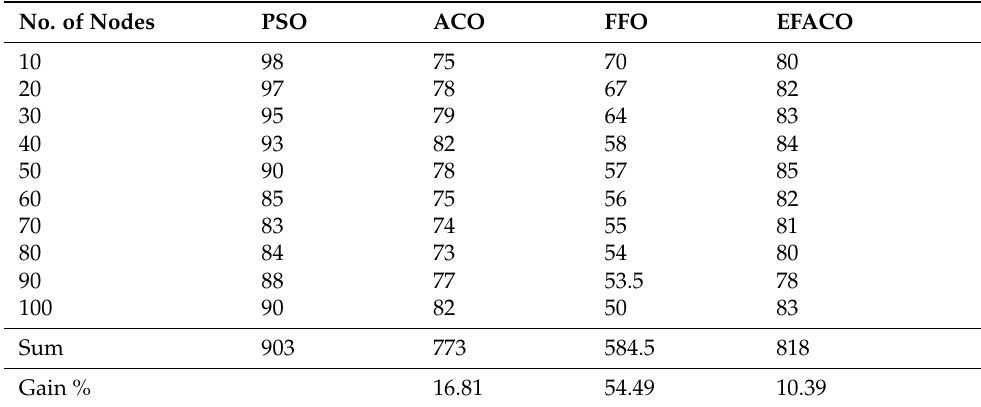
Figure 12. Comparison between proposed PSO, ACO, FFO, EFACO for Packet Delivery Ratio with simulation time. Table 4. Packet Delivery Ratio in (%) in Figure